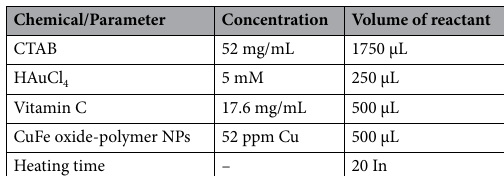
Table 3. The formula of Au/CuFe oxide-polymer NPs